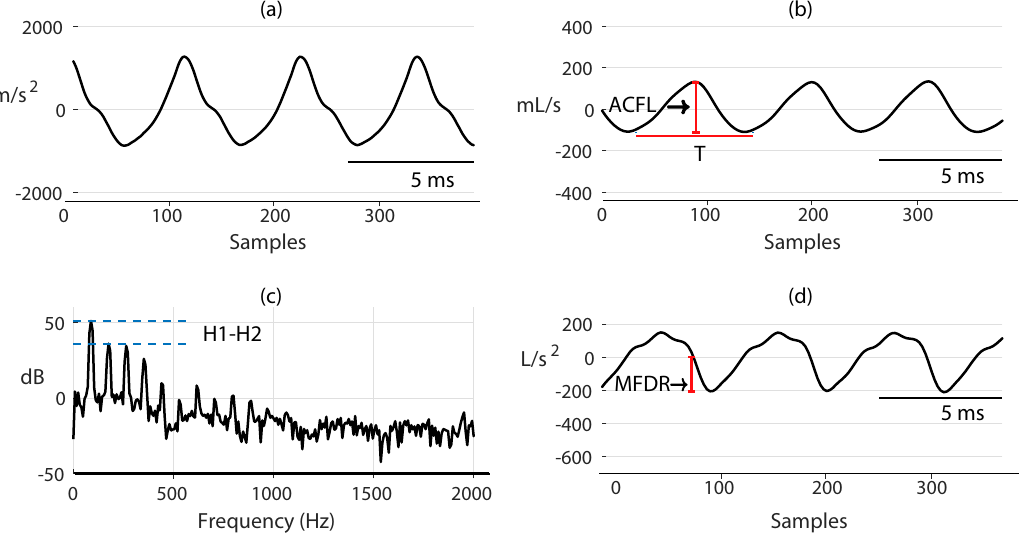
Figure 9. ( a ) ACC frame, ( b ) GVV frame, ( c ) spectrum from ( b ), and ( d ) time-derivative from ( b